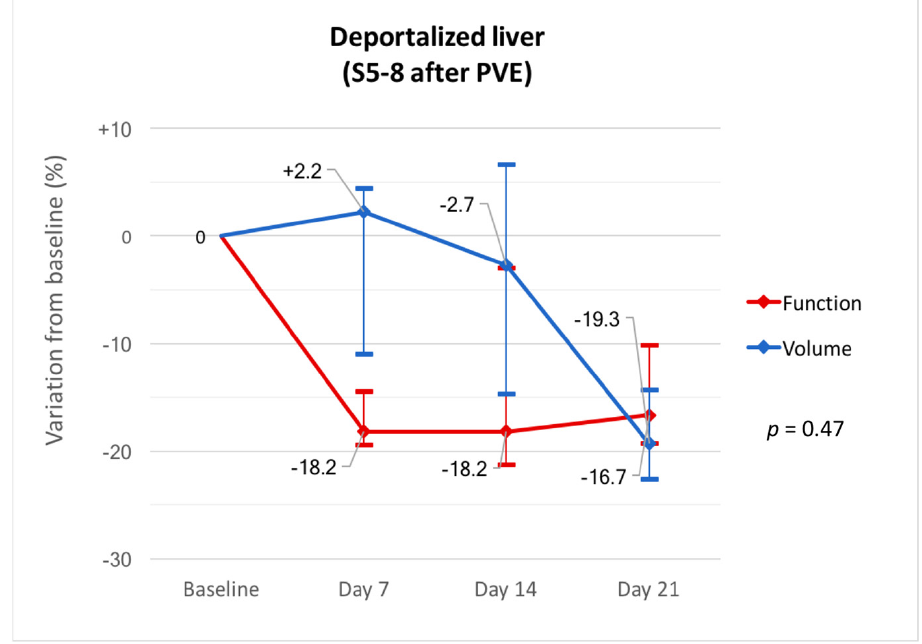
Figure 2. Variations in volume and function from baseline in the deportalized liver (S5-8) at days 7, 14 and 21 after